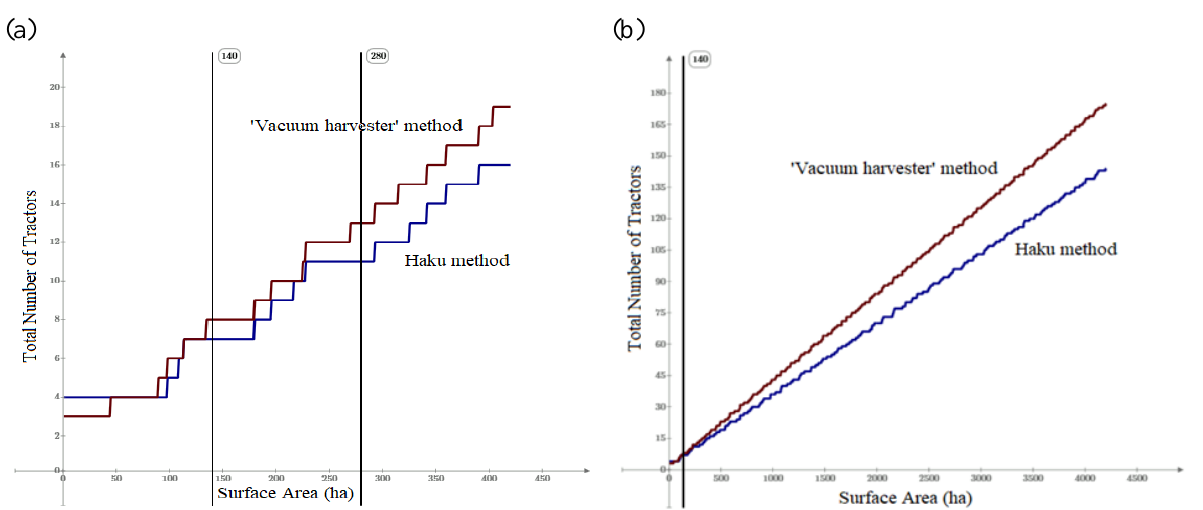
Figure 5. (a) Total number of tractors (Stage 1 fleet) required for peat extraction by the Haku and ‘vacuum harvester’ methods on surface areas up ~400 ha. Surface areas 140 ha and 280 ha are indicated by vertical markers. (b) Total number of tractors (Stage 1 fleet) required for peat extraction by the Haku and ‘vacuum harvester’ methods on surface areas up to thousands of hectares. In (b) the linear relationship between the number of towing machines and the surface area of the peat field becomes